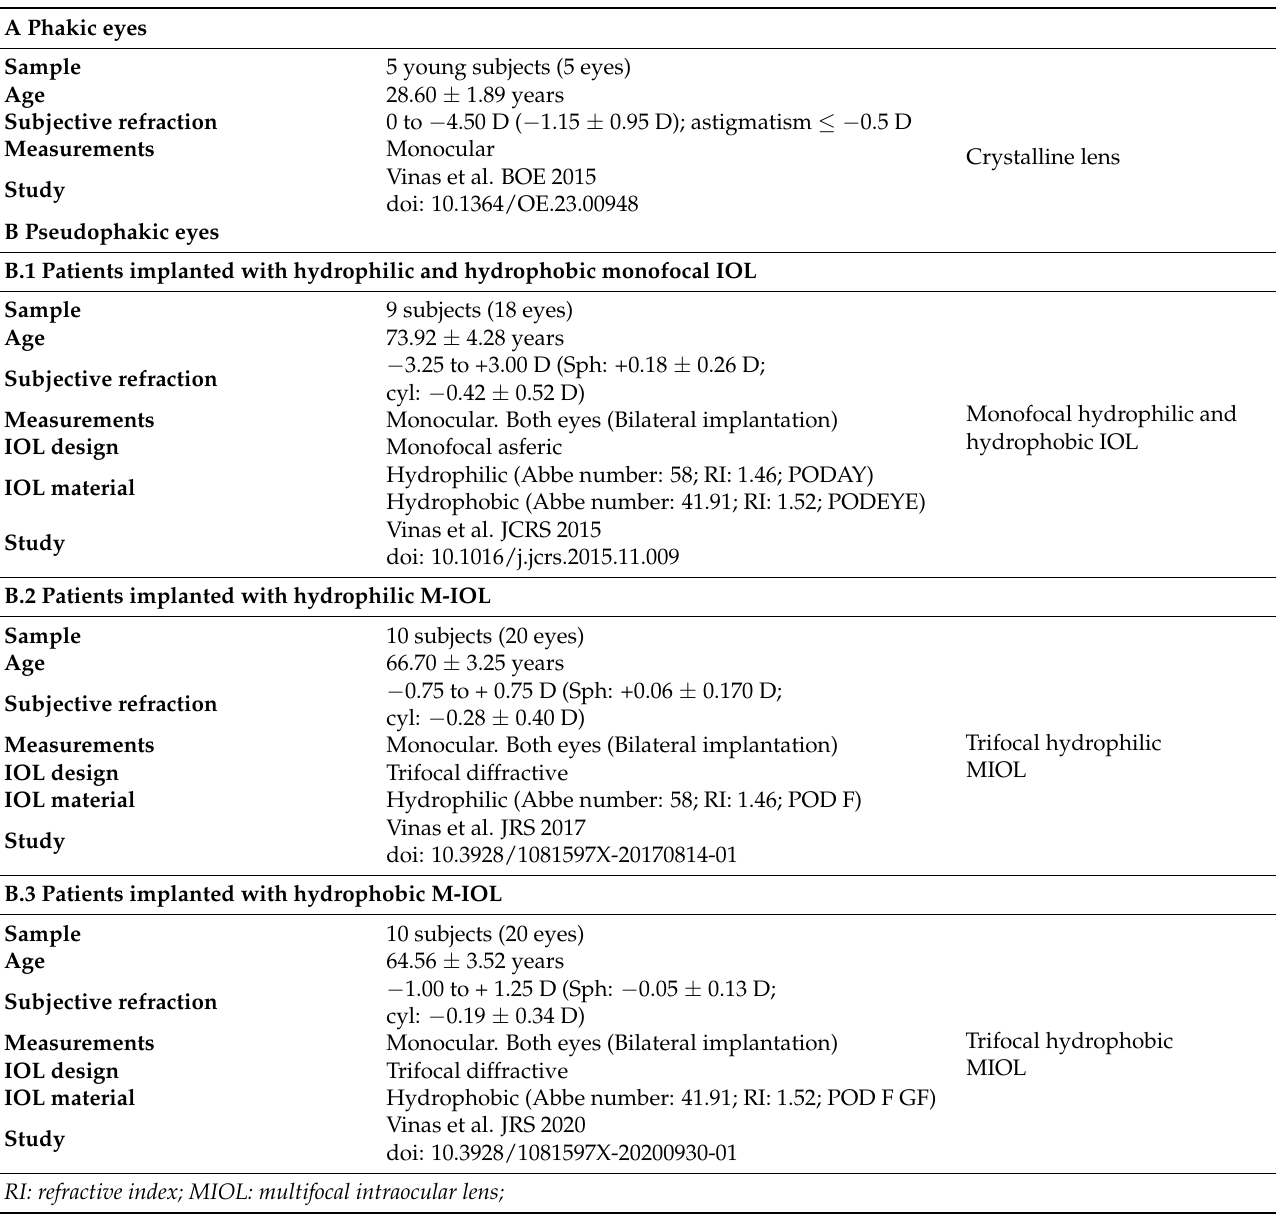
Table 1. Refractive and IOL profile of the patients participating in the different